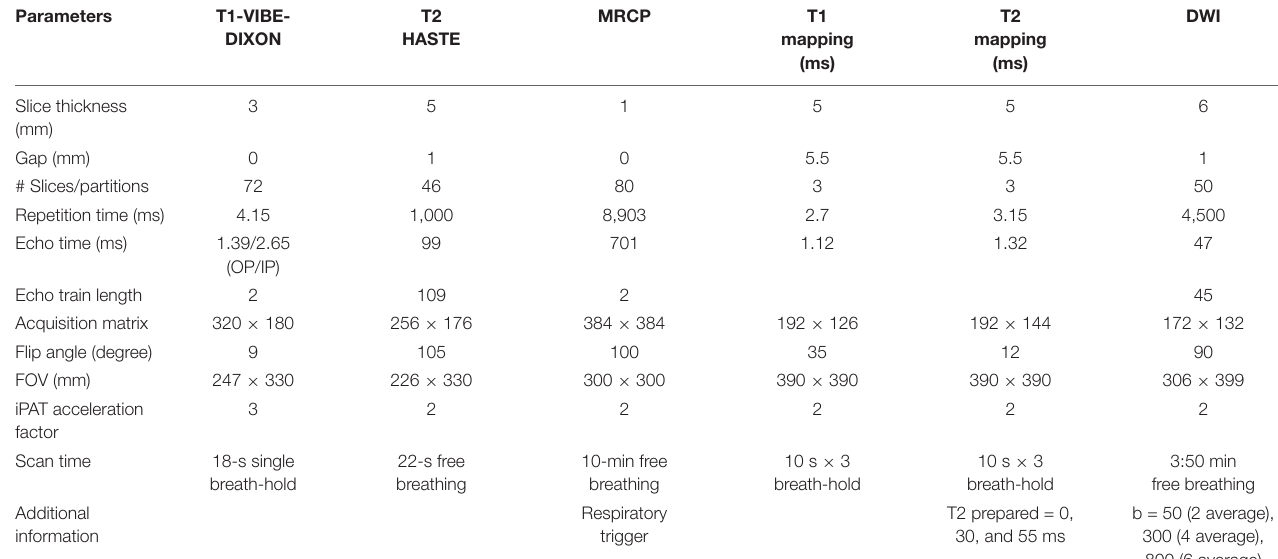
TABLE 1 | Parameters of all MRI sequences used in the